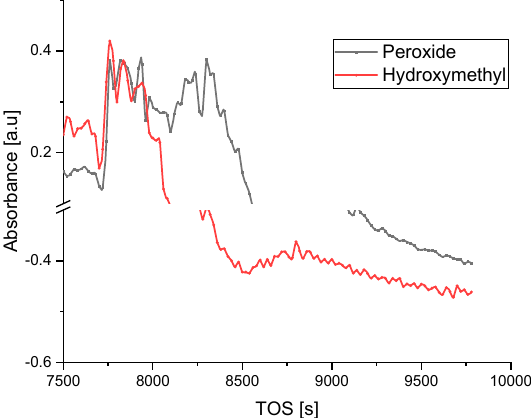
Figure 6. Transient behavior of peroxide and hydroxymethyl species.